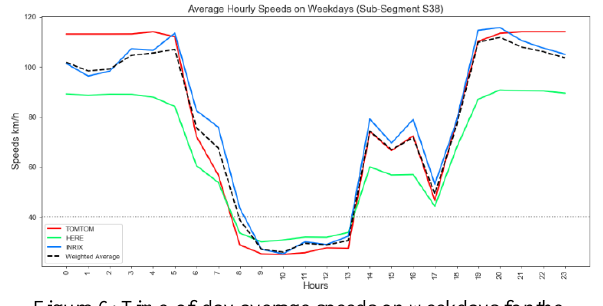
Figure 6: Time-of-day average speeds on weekdays for the virtual sub-segment before the bottleneck location (S38).